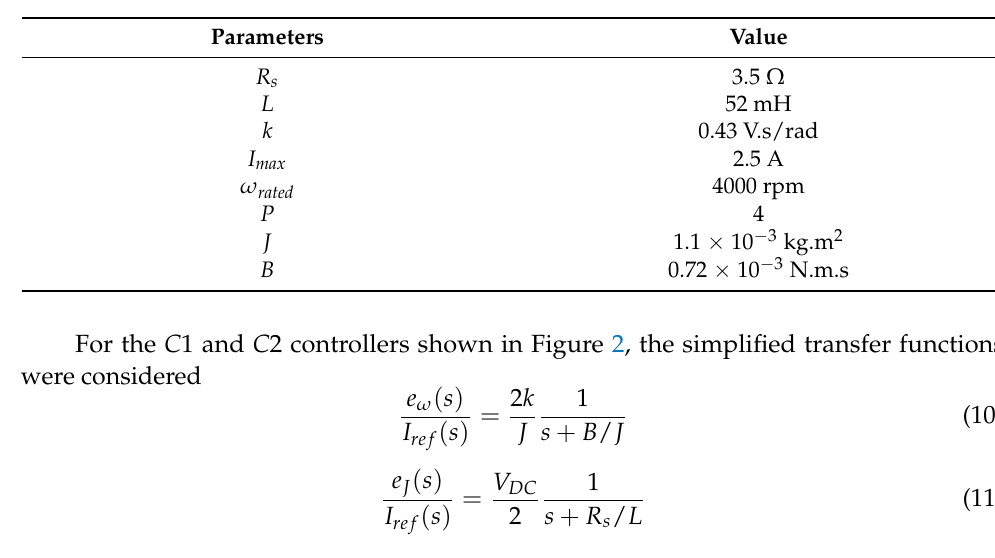
Figure 5. Numerical simulation of a BLDC motor under fault in phase c in 180 ◦ Six-Step operation mode: ( a ) speed; ( b ) induction voltage E ab ; ( c ) phase currents I a , I b and I c .